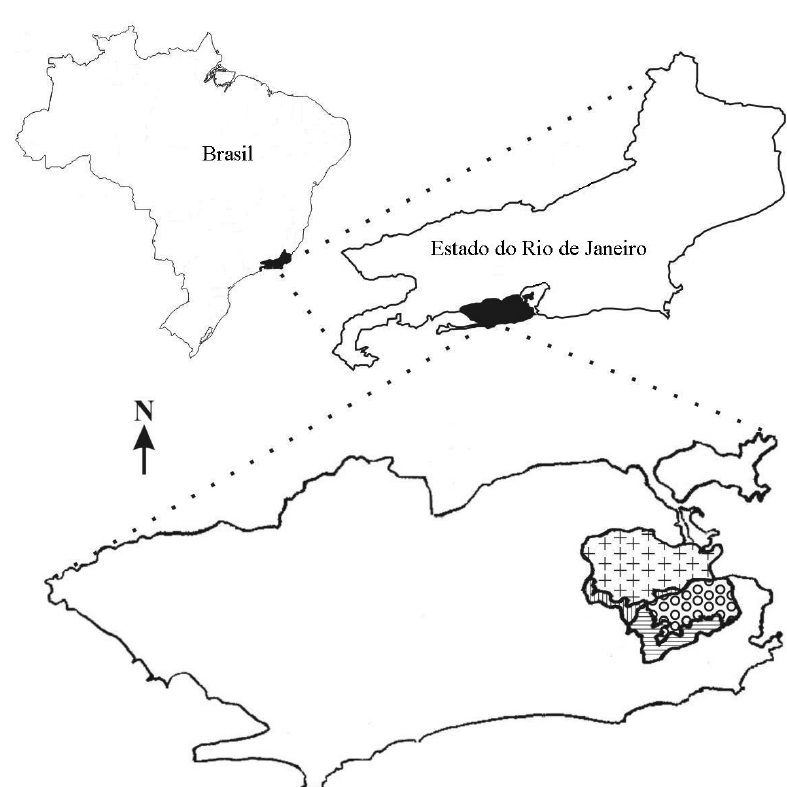
Figura 1. Localização e mapa do município do Rio de Janeiro, mostrando as sub-bacias dos canais do Cunha (linhas verticais, para área mapeável, e sinais em cruz, para área urbanizada) e do Mangue (linhas horizontais, para área mapeável, e círculos, para área